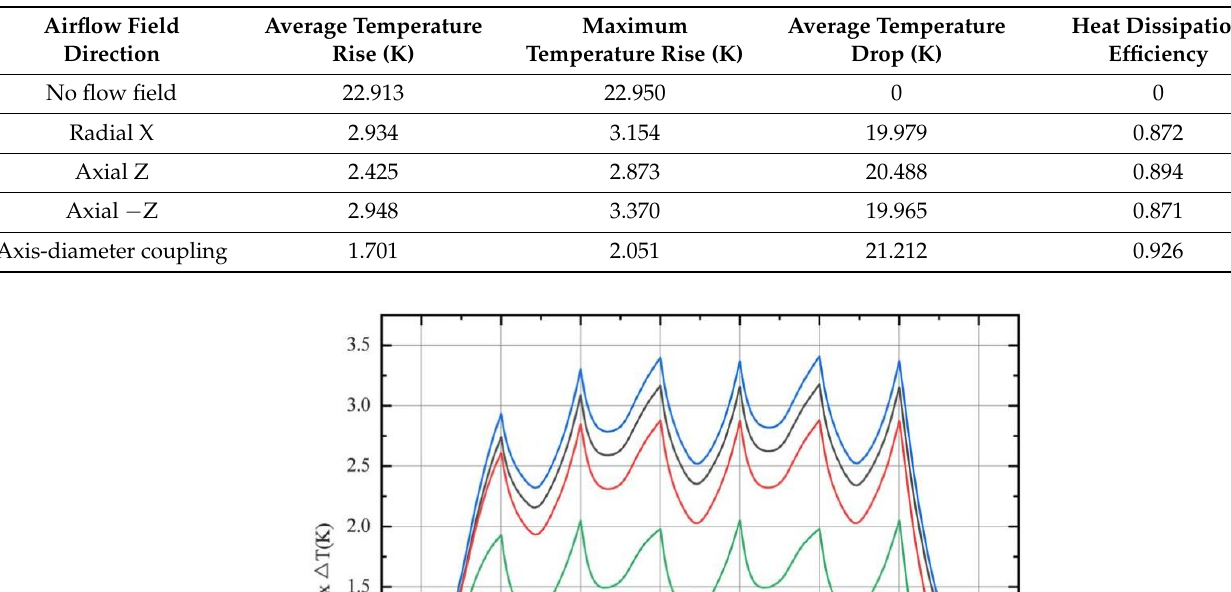
Figure 15. Comparison of heat dissipation capacity in airflow field direction. ( a ) radial X airflow field direction; ( b ) radial Z airflow field direction; ( c ) radial − Z airflow field direction; ( d ) axial–radial coupling airflow field direction. Table 4. Comparison of airflow field direction.